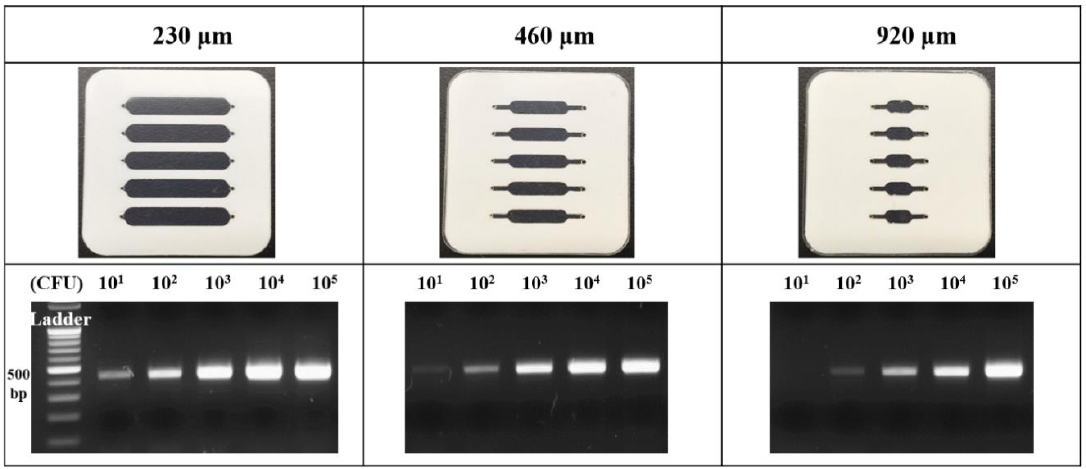
Figure 4. The fabricated three type film PCR chip as designed and optical images for Bacillus cereus gene amplification result. The 1.0 × 10 1 to 1.0 × 10 5 CFU mL − 1 Bacillus cereus was evaluated.